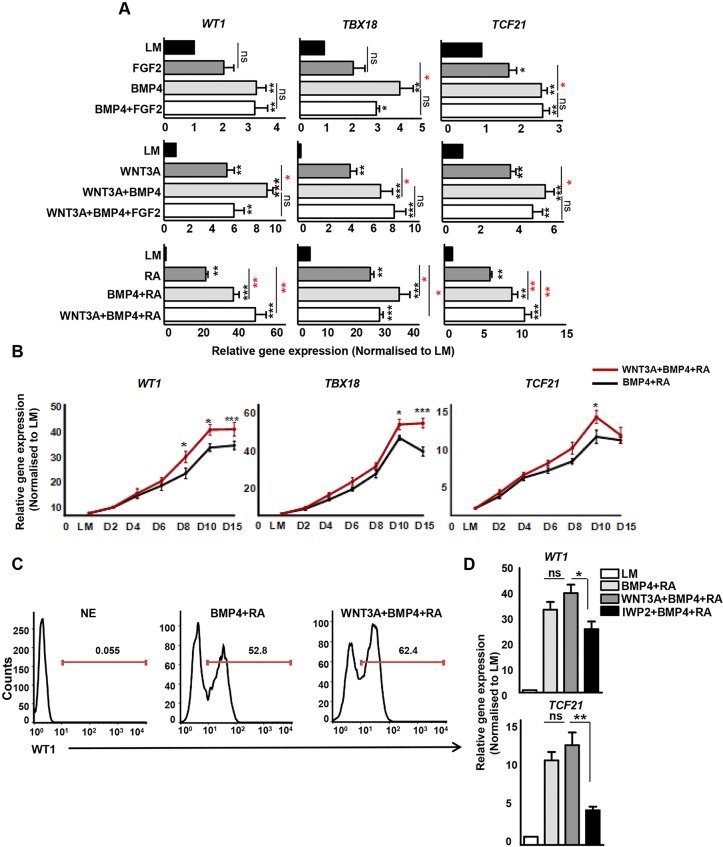
WNT3A, BMP4 and RA are key regulators of LM differentiation to epicardium. (A) Expression of epicardial genes by qRT-PCR in epicardium-like cells generated from LM after 10 days of treatment with different combinations of FGF2, BMP4, WNT3A and retinoic acid (RA). Significant differences compared with LM are indicated in black, whereas intergroup differences are indicated in red. ***P<0.001, **P<0.01, *P<0.05. (B) Temporal expression of epicardial genes in BMP4+RA- and WNT3A+BMP4+RA-treated cells determined by qRT-PCR. ***P<0.001, *P<0.05. (C) Percentage of WT1+ cells in BMP4+RA and WNT3A+BMP4+RA-treated day 10 epicardial cells. H9-derived neuroectoderm (NE) served as negative control. (D) Inhibition of endogenous WNT signalling by differentiating LM with IWP2 resulted in reduced expression of epicardial genes (WT1 and TCF21). **P<0.01, *P<0.05.